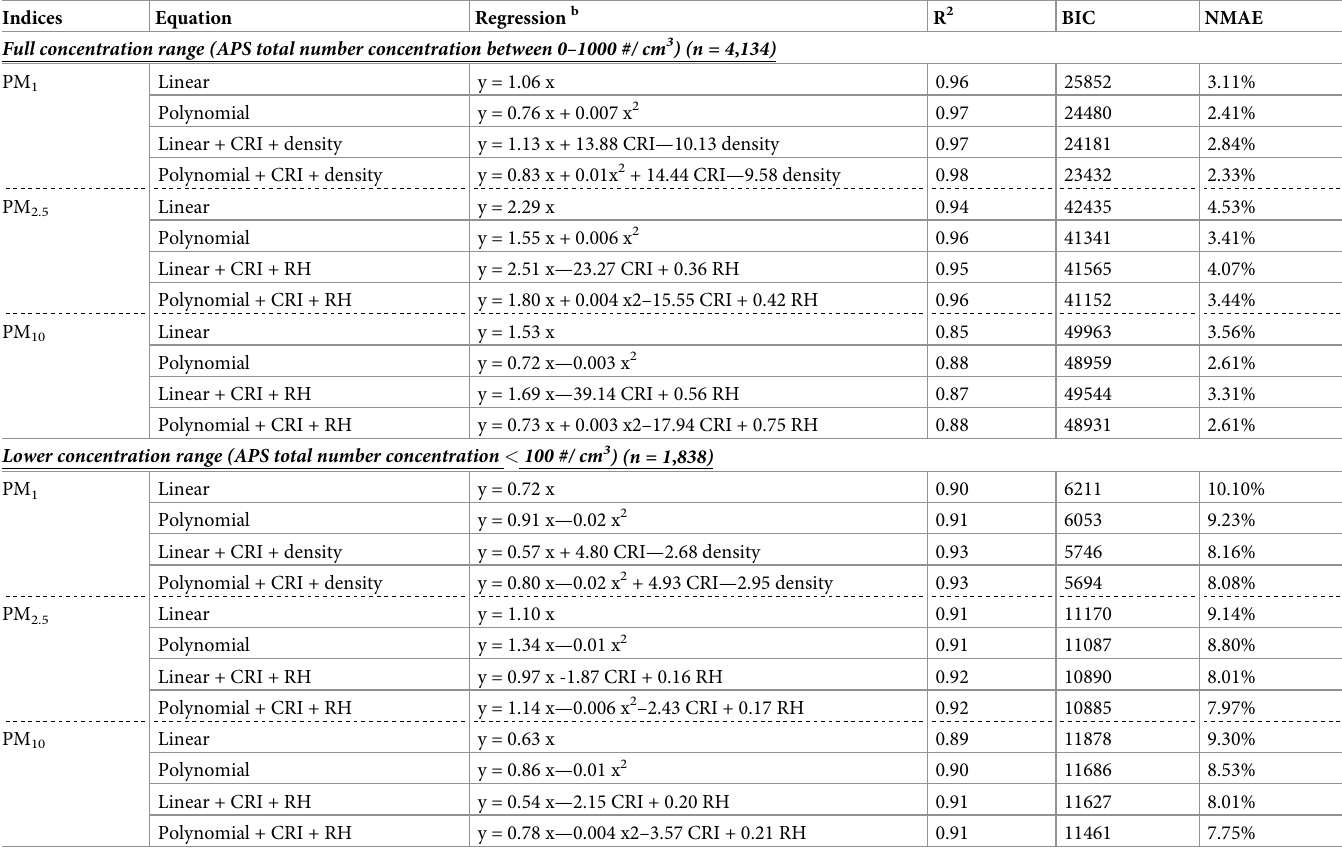
a The APS mass concentration measurement was obtained with the assumed density for testing aerosols in Table 1.